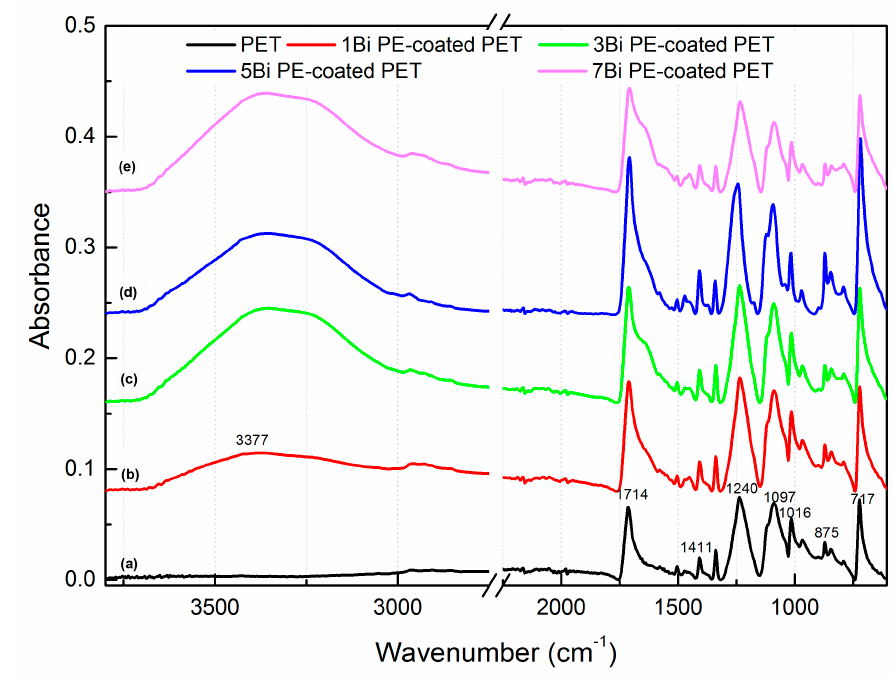
Figure 4. Fourier transform infrared (FTIR) spectra of PET fabric (a) and PET fabrics coated with (b) 1, (c) 3, (d) 5, and (e) 7 bilayers of PE multilayers, respectively.